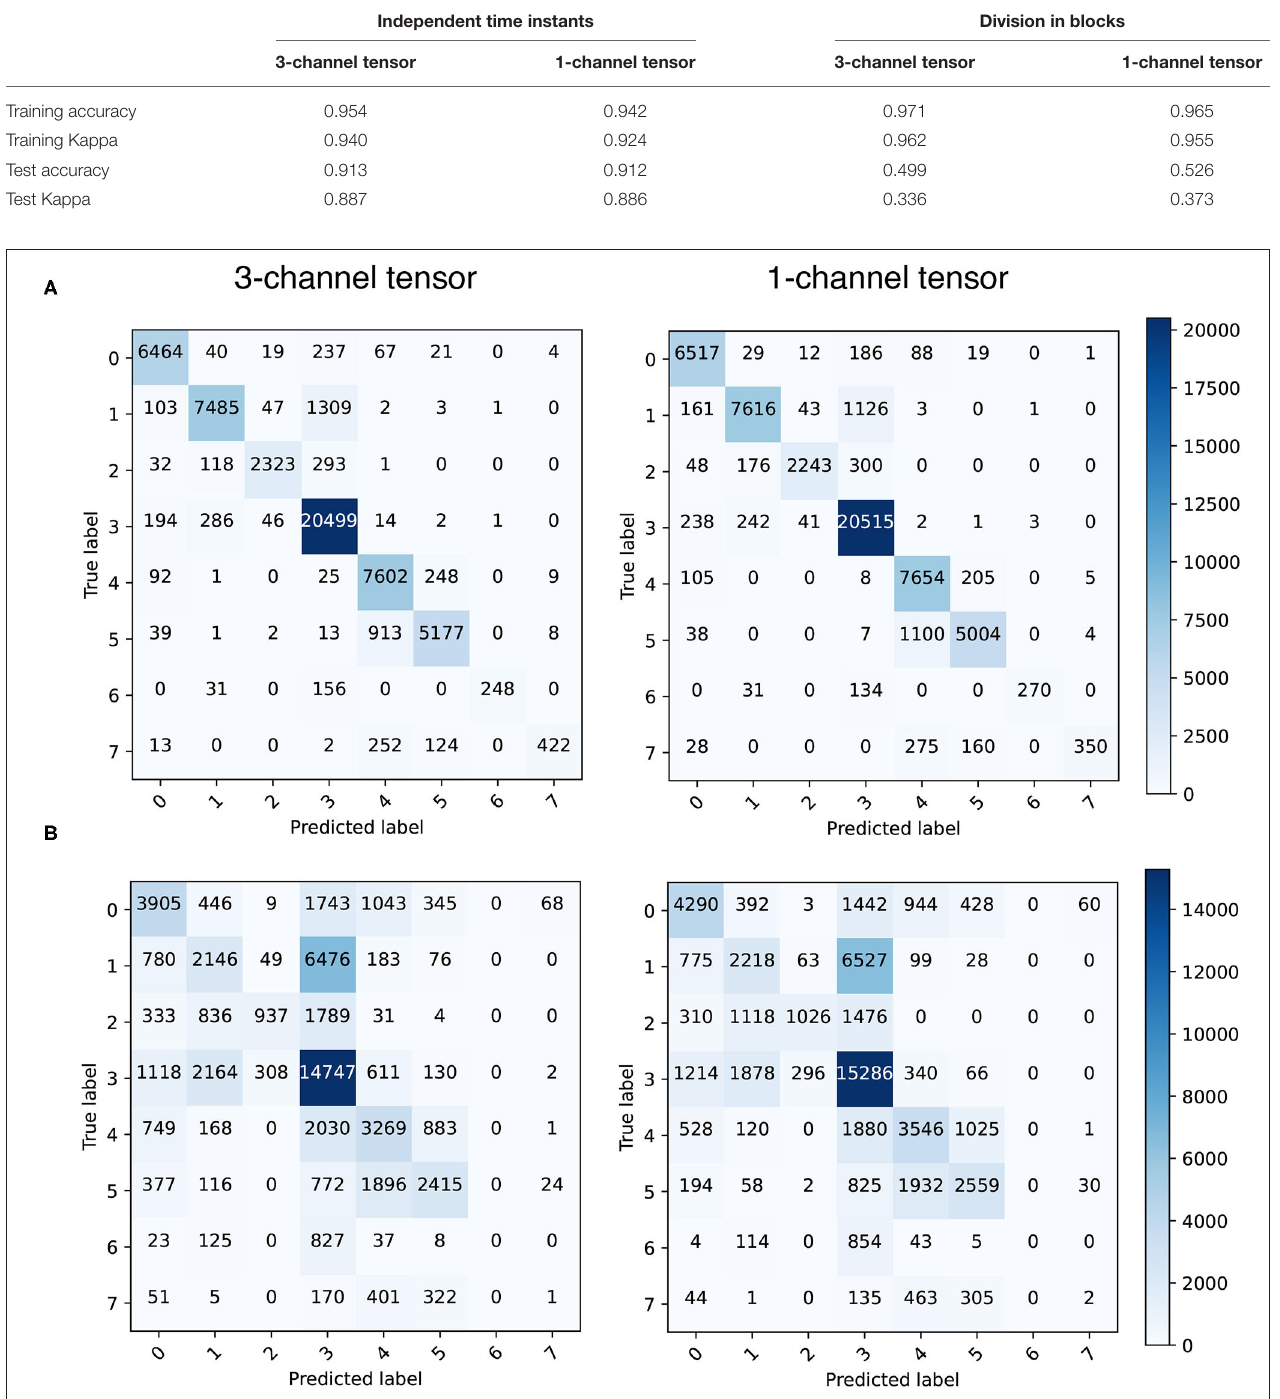
TABLE 1 | Performance metrics obtained with CNN assuming independent time instants and division in blocks.